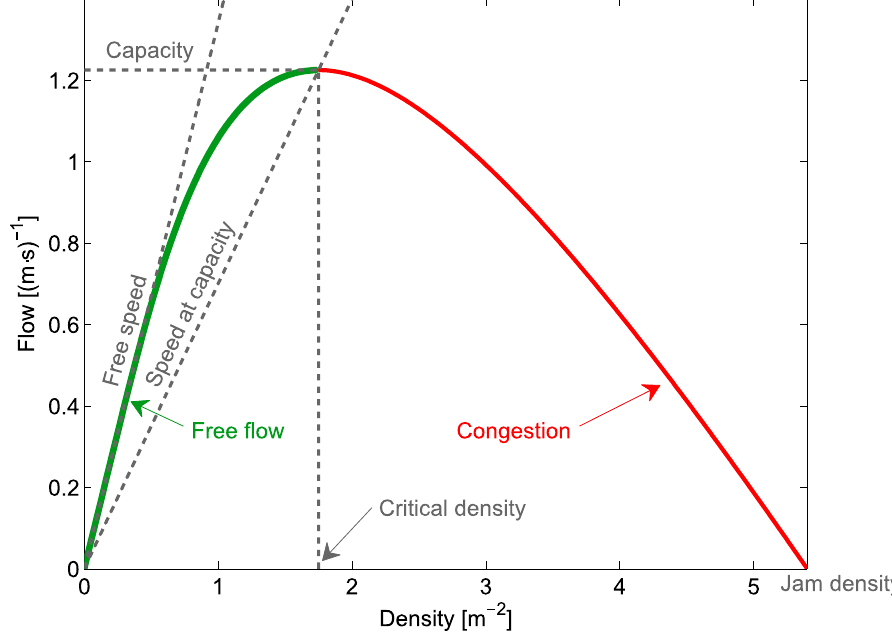
Fig 1. Fundamental diagram. Flow–density representation of the fundamental diagram for pedestrian motion [16]. Numerical values refer to the meta-study by Weidmann [17] and the function proposed by the same author.